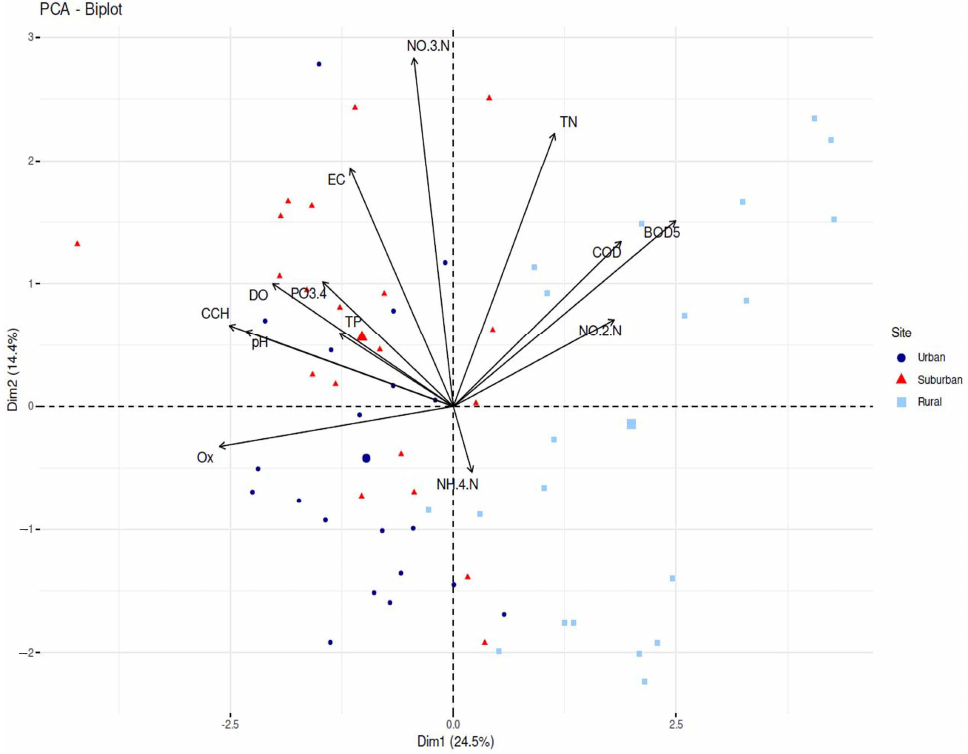
Figure 3. Principal components analysis of the 13 physicochemical parameters (factor weights) determining the ecological status on the three sites of Maritsa River for the period 2017–2019.